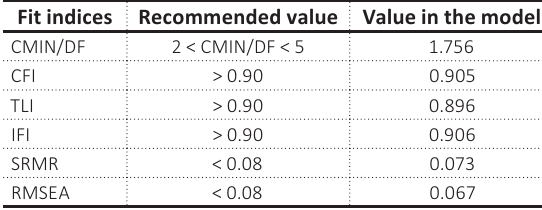
Table 4. Goodness-of-fit indicators in the structural model